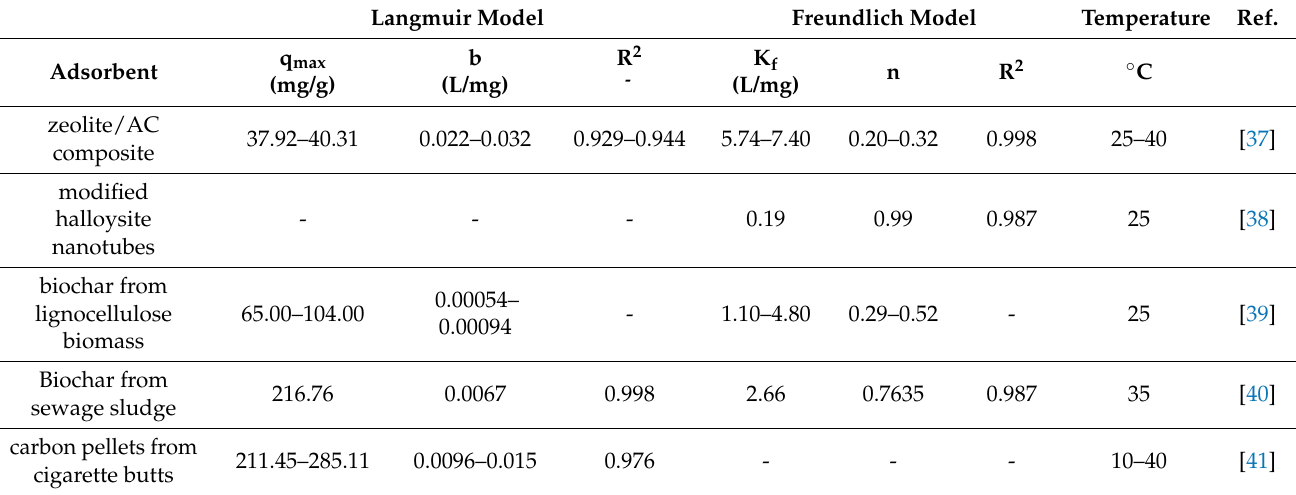
Table 7. Performances of some non-commercial adsorbents tested for the removal of phenol. Langmuir Model Freundlich Model Ref.